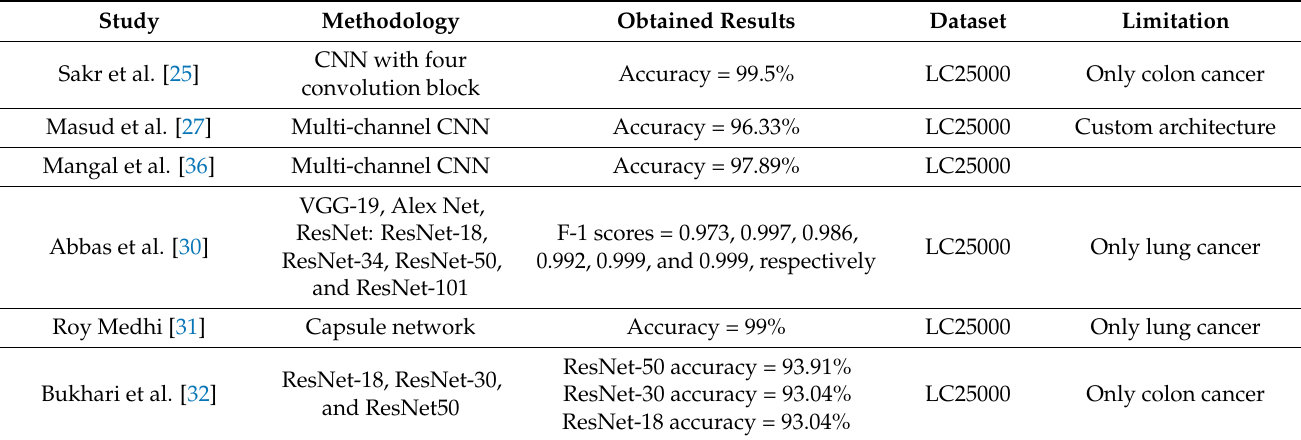
Table 1. Summary of existing methods for colon and lung cancer